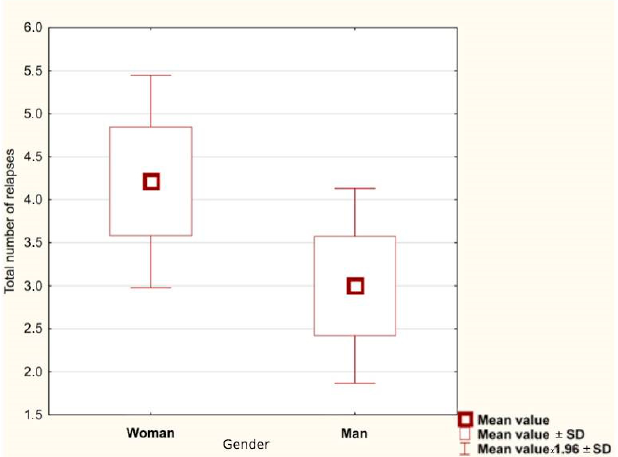
Figure 2. Total number of relapses in women and men (average value).